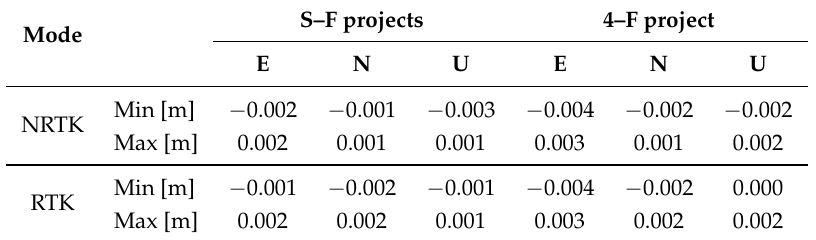
Table 4. Minimum and maximum coordinate difference due to SP identification by different